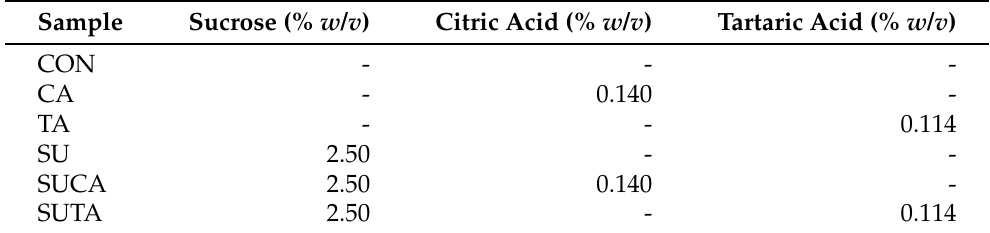
Table 1. Sample names and concentrations of taste stimuli in either aqueous solution or cold-brewed coffee. Samples are control (CON), Citric Acid (CA), Tartaric Acid (TA), Sucrose (SU), Sucrose, and Citric Acid (SUCA), and Sucrose and Tartaric Acid (SUTA).